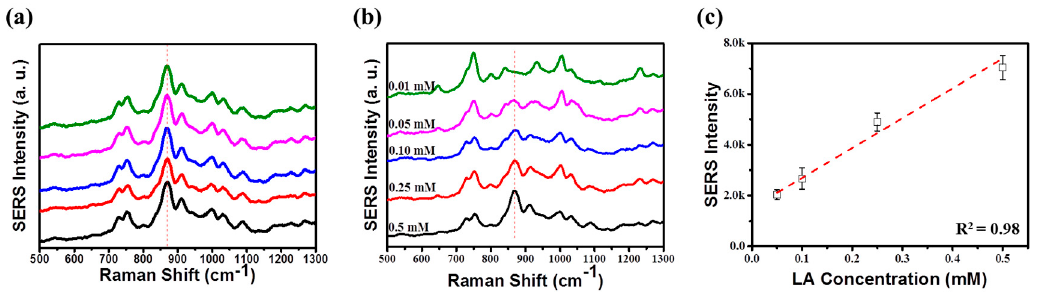
Figure 5. ( a ) Raman spectra of 0.5 mM lactic acid (LA) measured from the five random spots of quasi-3D nanowell structures. The characteristic peak of lactic acid at 869 cm − 1 peak was used to assess the signal uniformity. The RSD was as small as 6.8% at 869 cm − 1 . ( b ) Comparison of the Raman spectra of lactic acid obtained from 0.5 mM to 0.01 mM lactic acid-treated 3D plasmonic nanostructures. ( c ) Calibration plot with four known concentrations. The SERS intensity at 869 cm − 1 was used for the calibration plot.